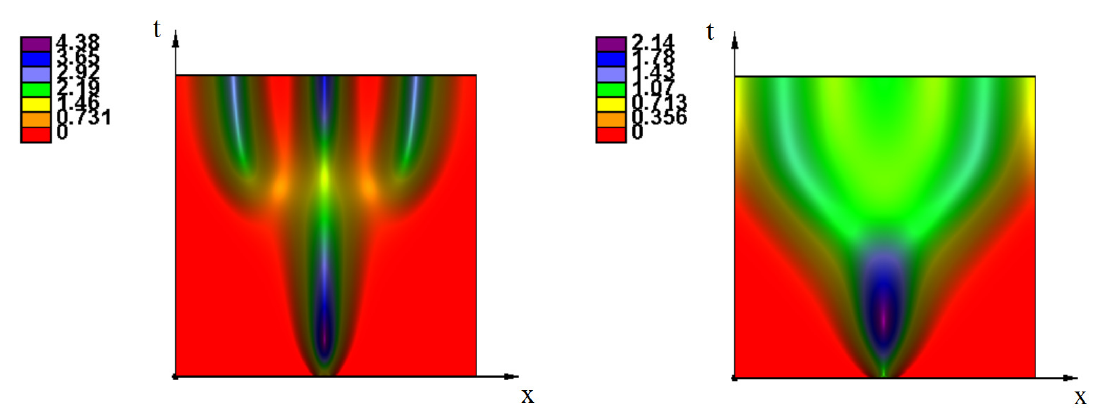
Figure A2. Level lines of the solution u ( x , t ) of Equation (1) on the ( x , t ) -plane. Values of parameters: r = 1, q = 1, N = 0.2, τ = 0, f ( u ) = 0 (left and middle), the maximum of the initial condition 0.9, D = 0.0001, t = 35 ( left ) and D = 0.0005, t = 20 ( right ).